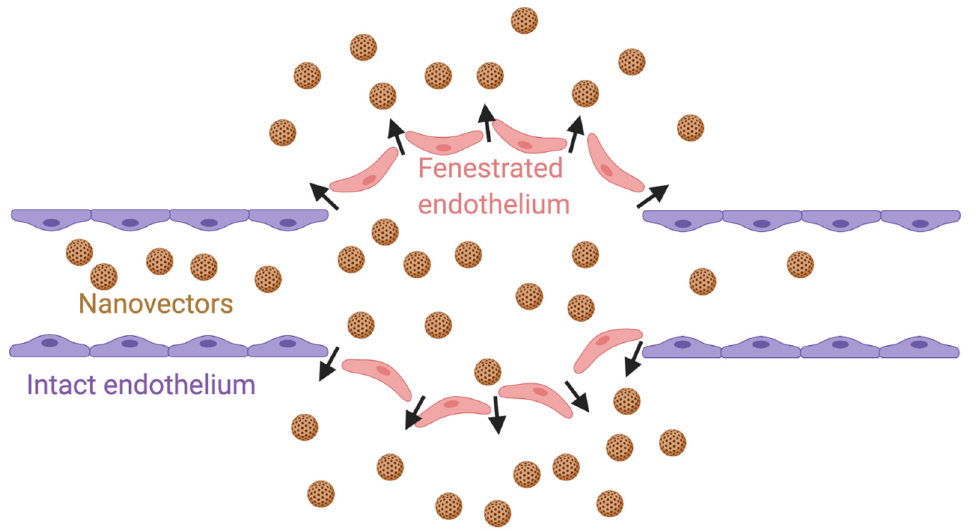
Figure 2. EPR effect. Nanovectors equipped with hydrophilic and flexible polymers escape opsonization and are able to diffuse selectively through the tumor vascular endothelium (orange color) but not through the endothelium of healthy tissue (blue color). (Created with Biorender; Adapted from [68], Collège de France, 2013.